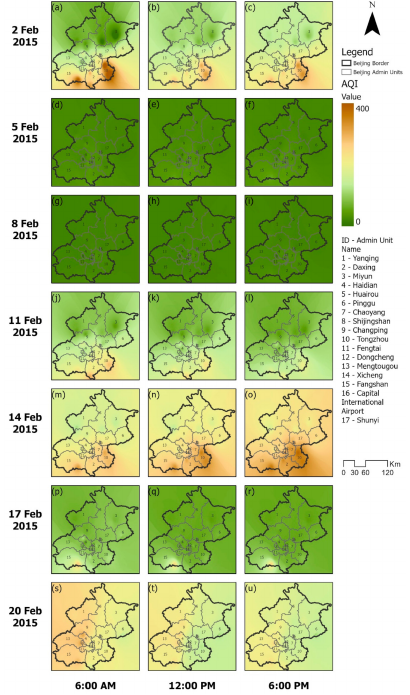
Figure A6. Twenty-one examples of the AQI distribution at different time points. In the layout of ( a – u ), every row shows the distributions of three time points: 6:00 a.m., 12:00 p.m., and 6:00 p.m. in the same day, while there are 7 days’ examples of date 2, 8, 11, 14, 17, and 20 in February 2015.